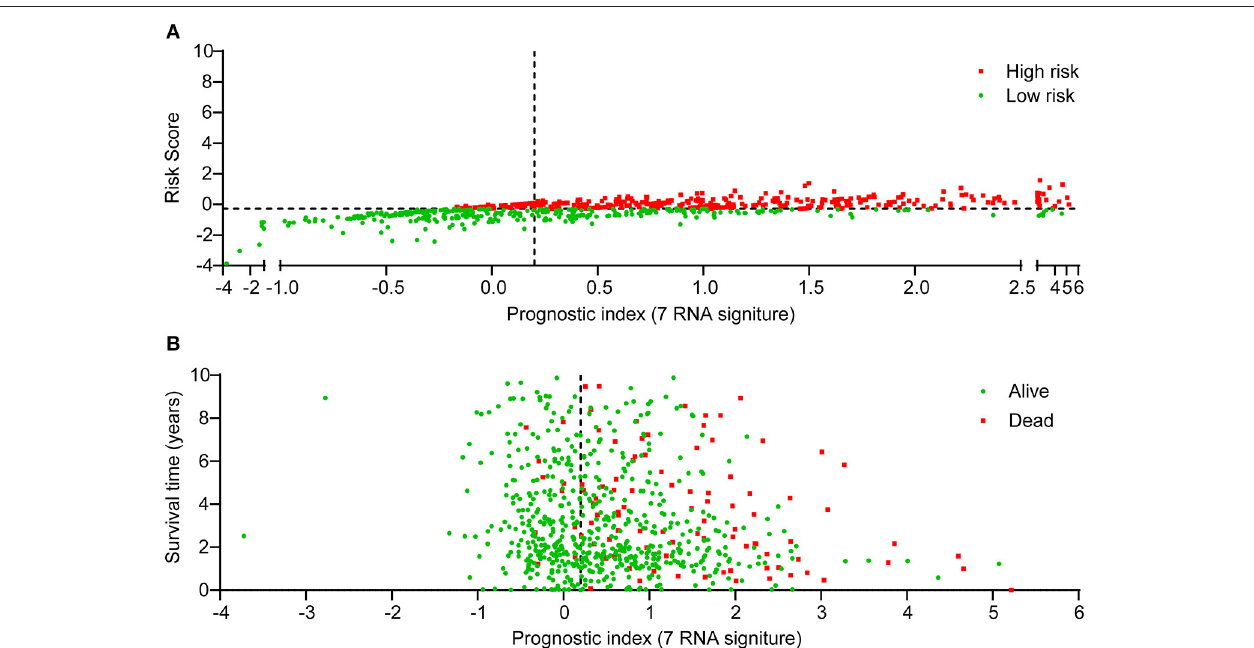
FIGURE 3 | The distribution of BRCA patients according to the risk score for pyroptosis-related gene signature. The 7-gene signature risk score ranged from − 3.865 to 1.572. The median value ( − 0.291) was used as cutoff point. Scatter plots were employed to indicate the risk score (A) and survival outcome (B) of each BRCA patient. “Dead” and “Alive” were represented by red and green dots in (B) ,